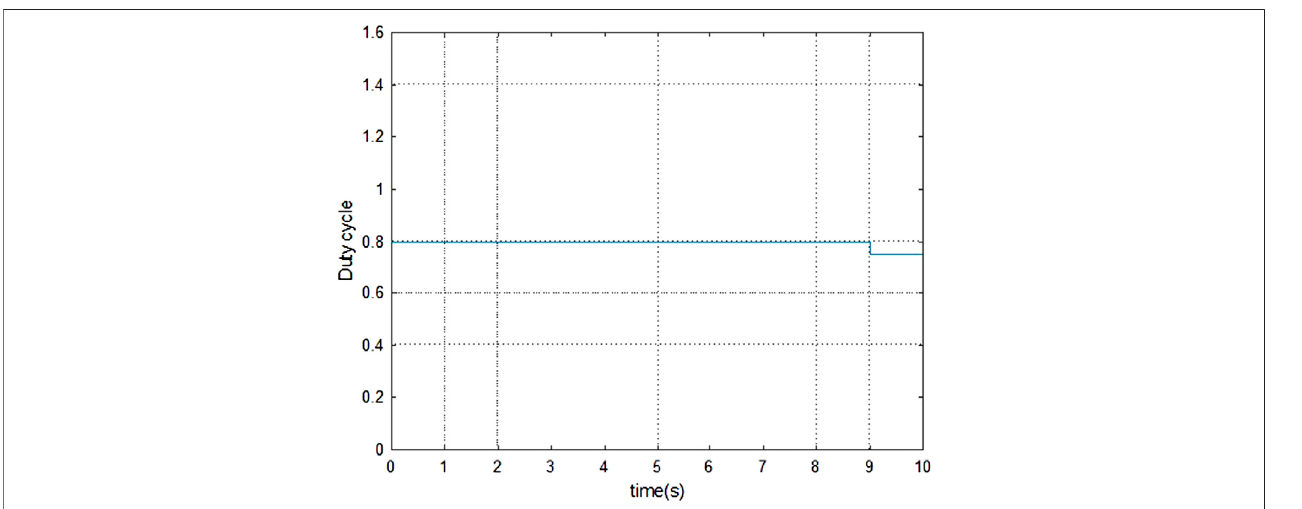
FIGURE 8 | Variation of the duty cycle for a smaller step size of Δ δ = 0.001.